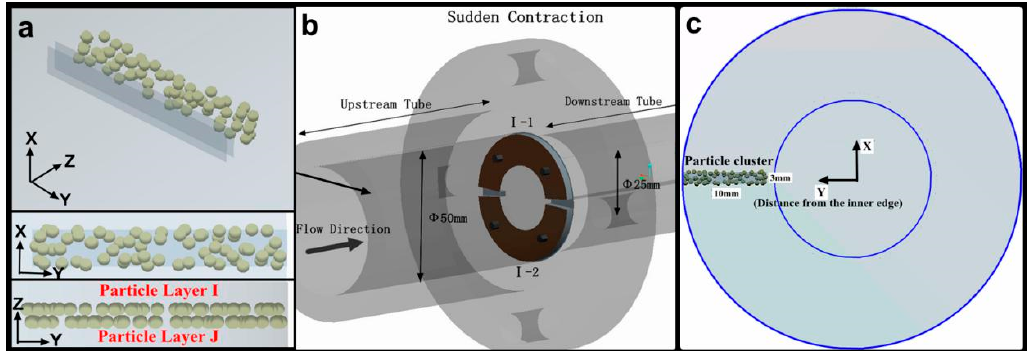
Figure 4. Structure of the contraction section and the super 13Cr samples, ( a ) the distribution and arrangement of the particles in two particle layers; ( b ) the diagram of a sudden contraction section; ( c ) the location of a particle cluster. Table 3. CFD-DEM simulation parameters and geometric dimensions of the domain.